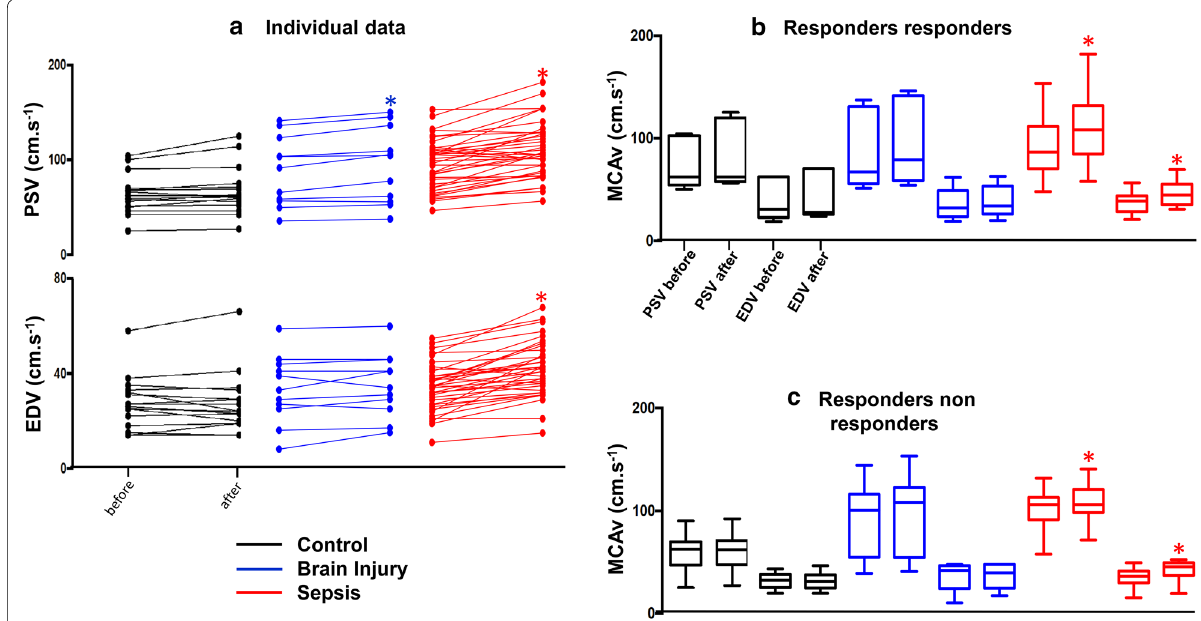
Fig. 2 a (Left side) The individual data for middle cerebral velocities before and after fluid challenge in the three studied groups: control (black color), brain injury (blue color) and septic patients (red color). The right side of the figure shows the box plot for the middle cerebral artery velocities (MCAv) at peak systole (PSV) and end diastole (EDV); b patients responding both in mean blood pressure and CO; c patients responding only in CO and not in mean blood pressure. * p value <